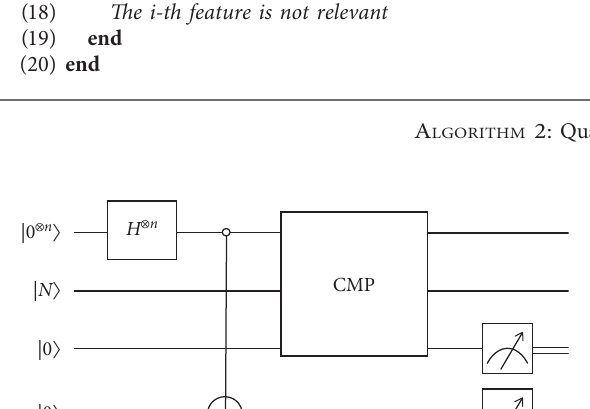
�� √ N ) 􏽐 N − 1 | i 〉 ; H is the i � 0